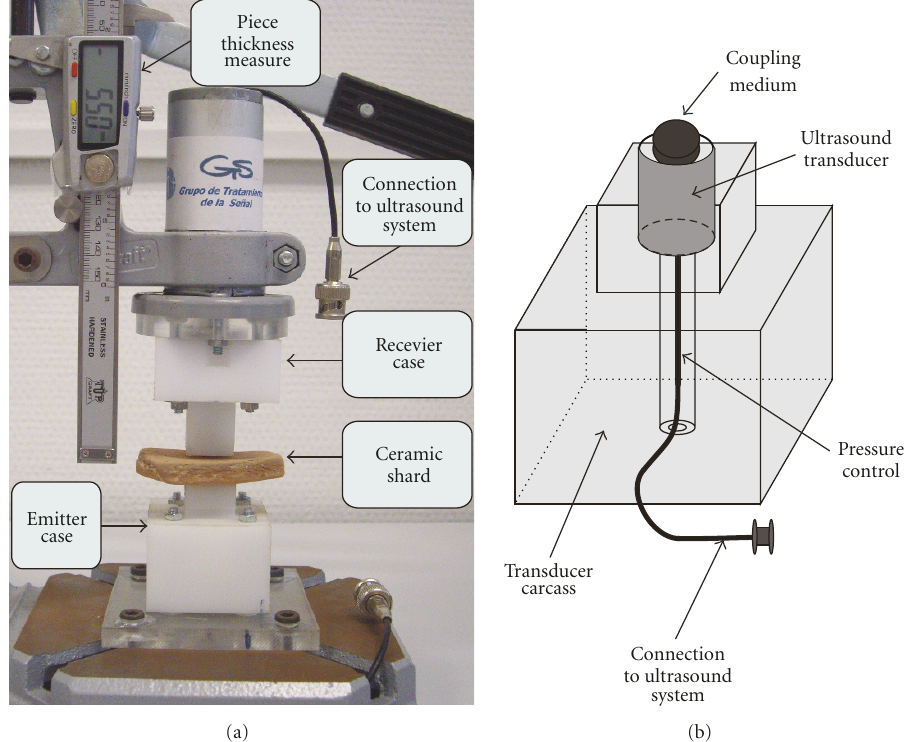
Figure 3: Measurement device employed in ultrasonic signal acquisition. A detail of the ultrasound transducer case is included.